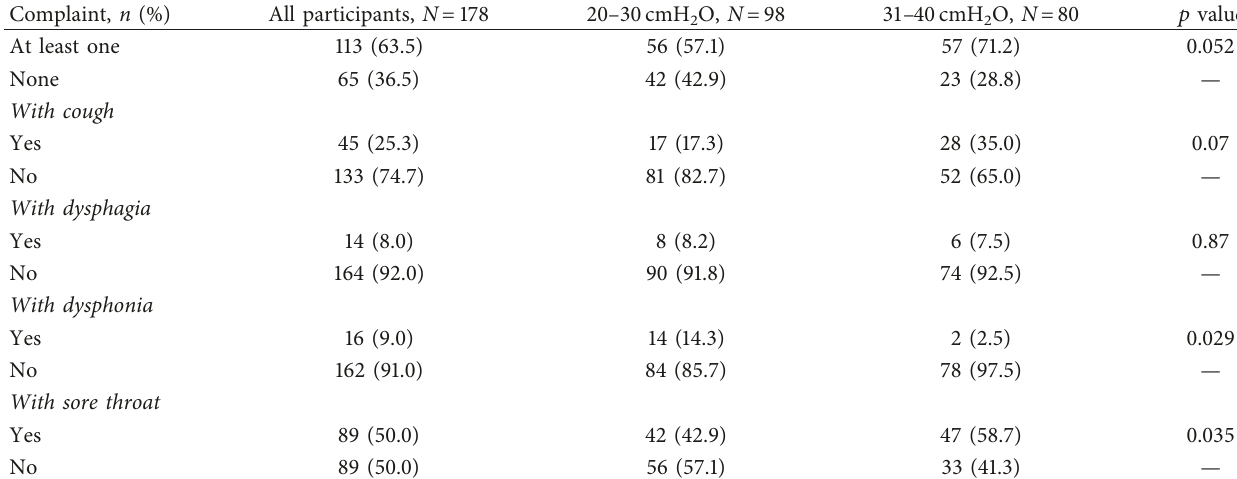
Figure 2: The distribution of cuff pressures achieved by the different levels of providers. 1: anesthesia resident; 2: anesthesia officer; 3: anesthesia officer student; 4: Table 3: Incidence of postextubation airway complaints in the study population.